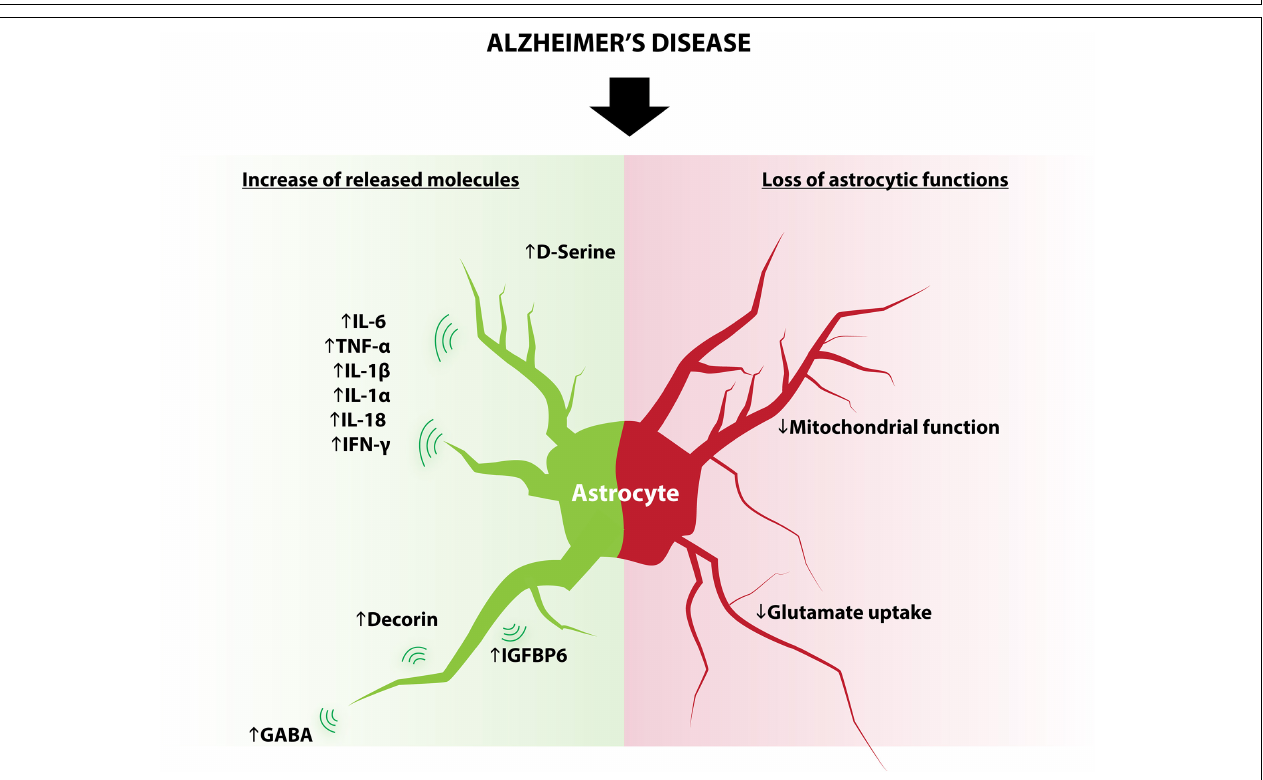
FIGURE 3 | Modifications of astrocytes in AD. Some astrocytic functions known to regulate adult neurogenesis are modified in AD and include: increased expression of D -serine, IL-6, TNF- α , IL-1 β , IL1- α , IL-18, IFN- γ , decorin, IGFBP6, GABA and decreased glutamate reuptake and mitochondrial